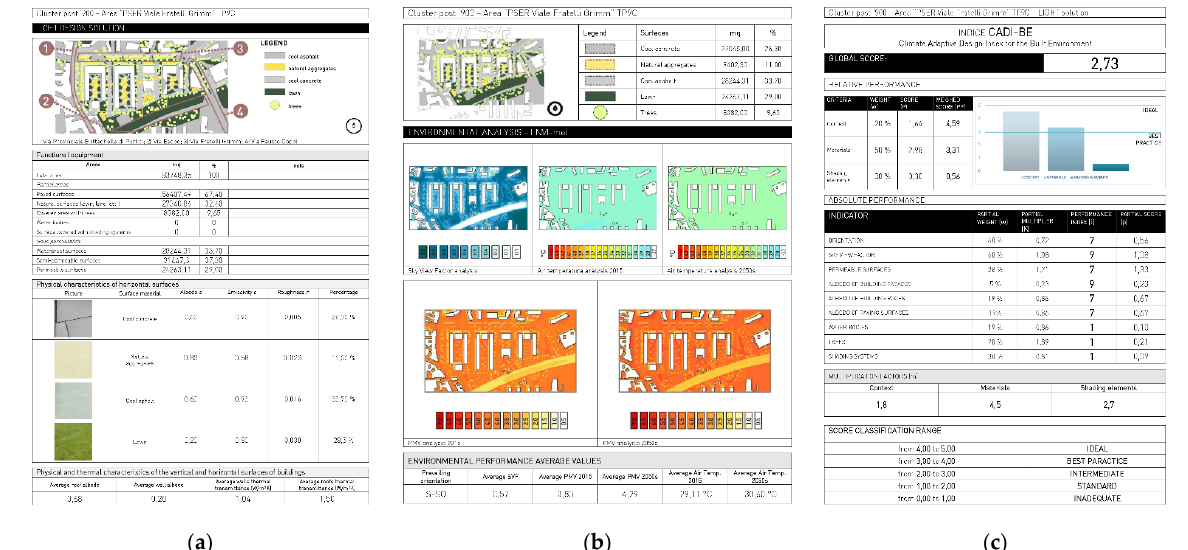
Figure 15. Registration of the TP9C test area in the actual condition: ( a ) technological analysis; ( b ) environmental analysis; ( c ) CADI-BE output.